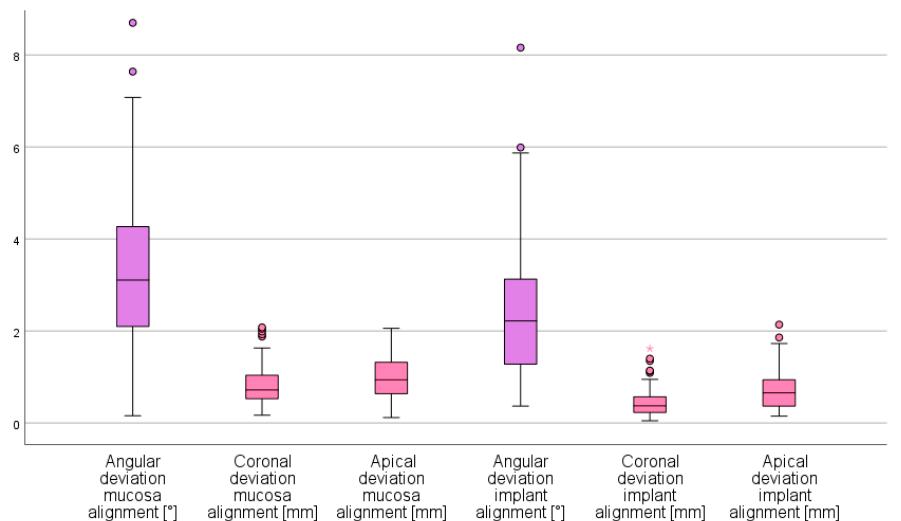
Figure 5. Boxplot representing the angular, coronal and apical implant deviation, based on the alignment of the soft tissue or implants. (outliers: : between 1.5 and 3 × IQ (interquartile range); * more than 3 × IQ.).